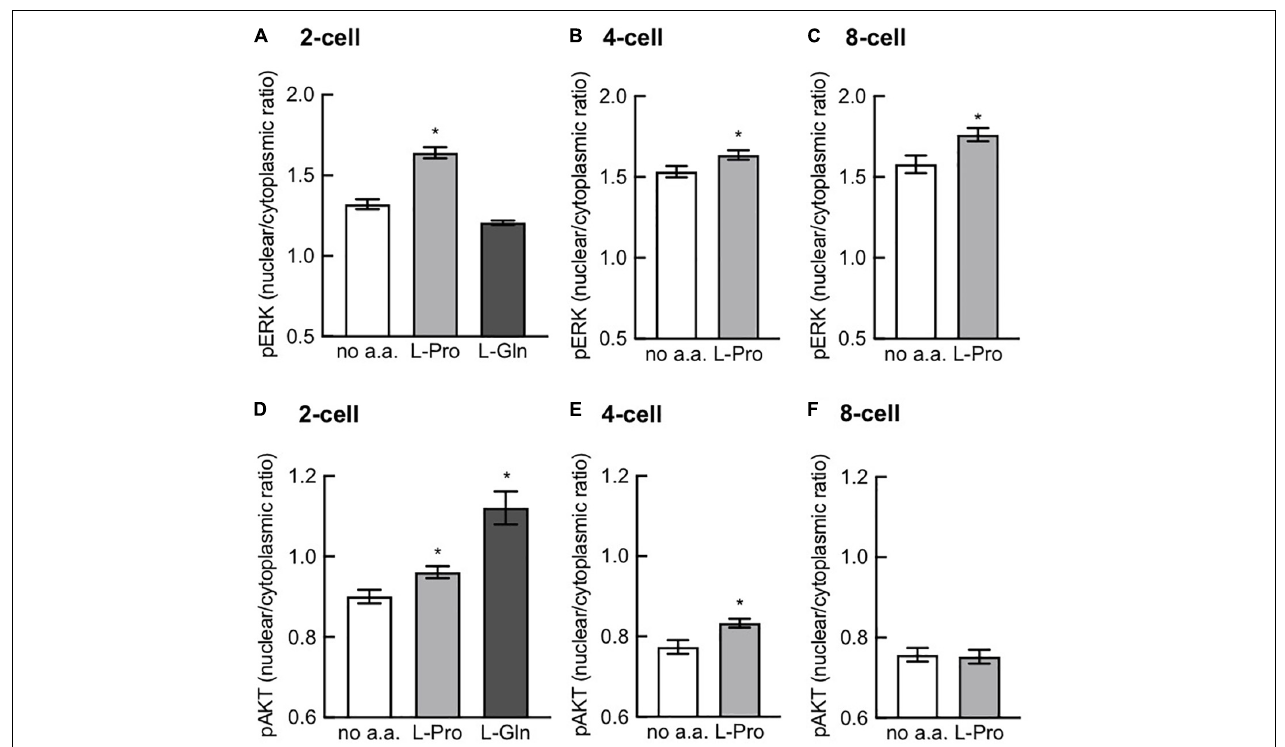
FIGURE 8 | Effect of L-Pro and L-Gln on nuclear translocation of p-ERK T202 / Y204 and p-Akt S473 . Zygotes (20–22 h post-hCG) were cultured for 2–3 days in no amino acids (no a.a.), 400 µ M L-Pro or 1 mM L-Gln and then fixed and immunostained for p-ERK T202 / Y204 (A–C) and p-Akt S473 (D–F) . Intensity of fluorescence in the nucleus and cytoplasm was measured and the nuclear-to-cytoplasmic ratio was calculated in 2-, 4-, and 8-cell embryos for L-Pro and in 2-cell embryos for L-Gln. Embryos were analyzed from at least three independent biological replicates with 5–10 embryos per experiment. Values are mean ± SEM. * P < 0.05 using an unpaired t -test (B,C,E,F) or one-way ANOVA with Dunnett’s post hoc test (A,D)